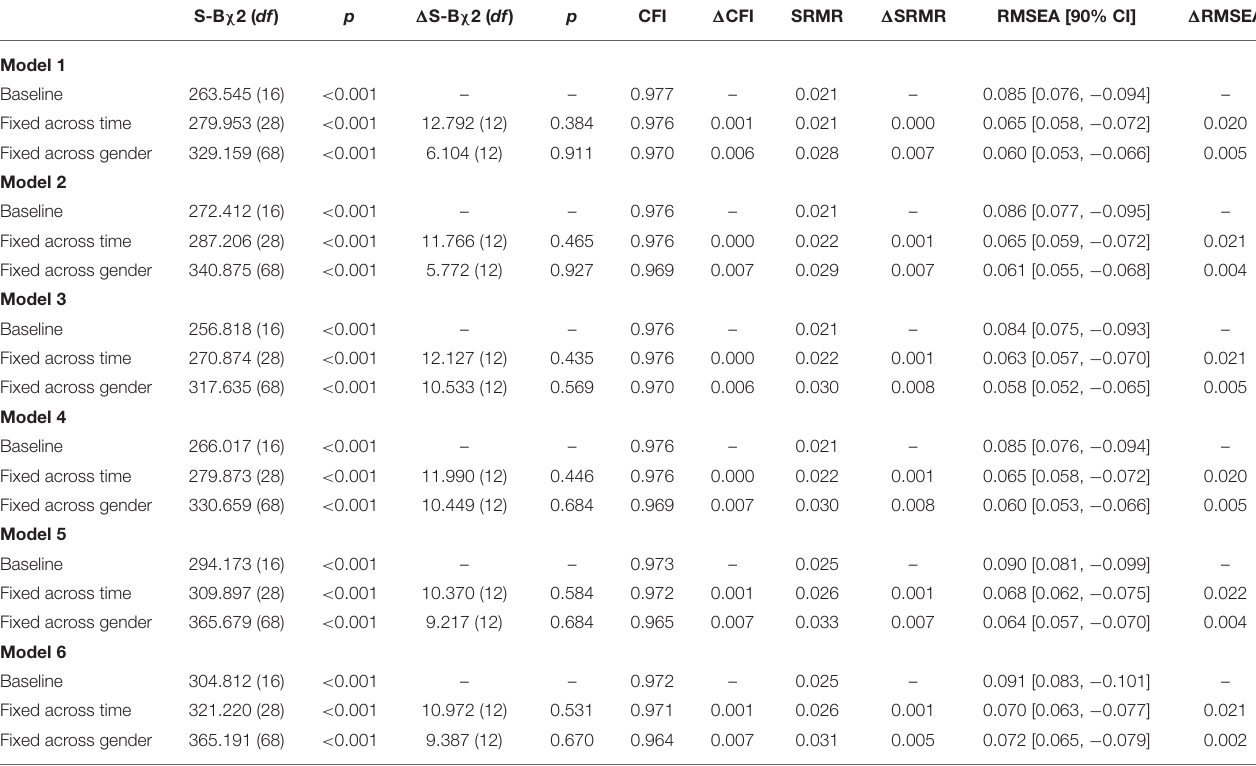
TABLE 3 | Fit indices for Cross-lagged Models at Baseline, Fixed across Time, and Fixed across